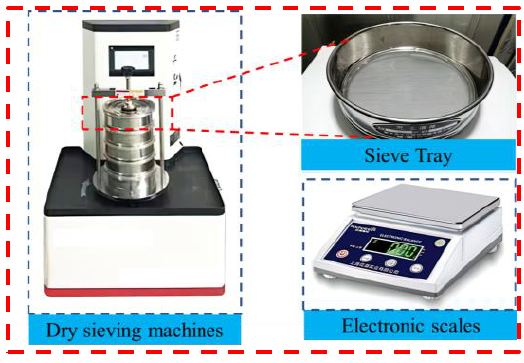
Figure 4. Test of dry